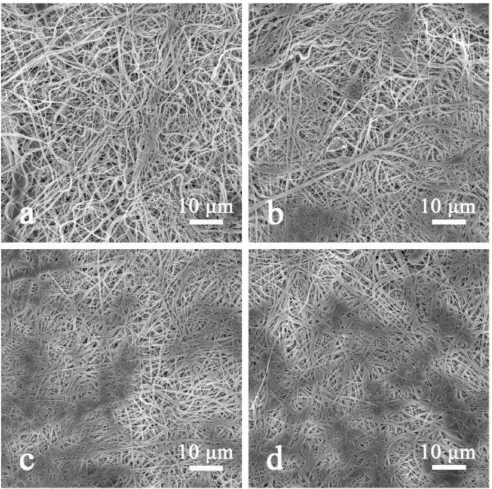
Figure 3. SEM images of composite hot-pressed nylon 6 nanofibrous membrane (HNM) under different pressures in hot pressing: ( a ) 0 MPa, ( b ) 5 MPa, ( c ) 10 MPa and ( d ) 15